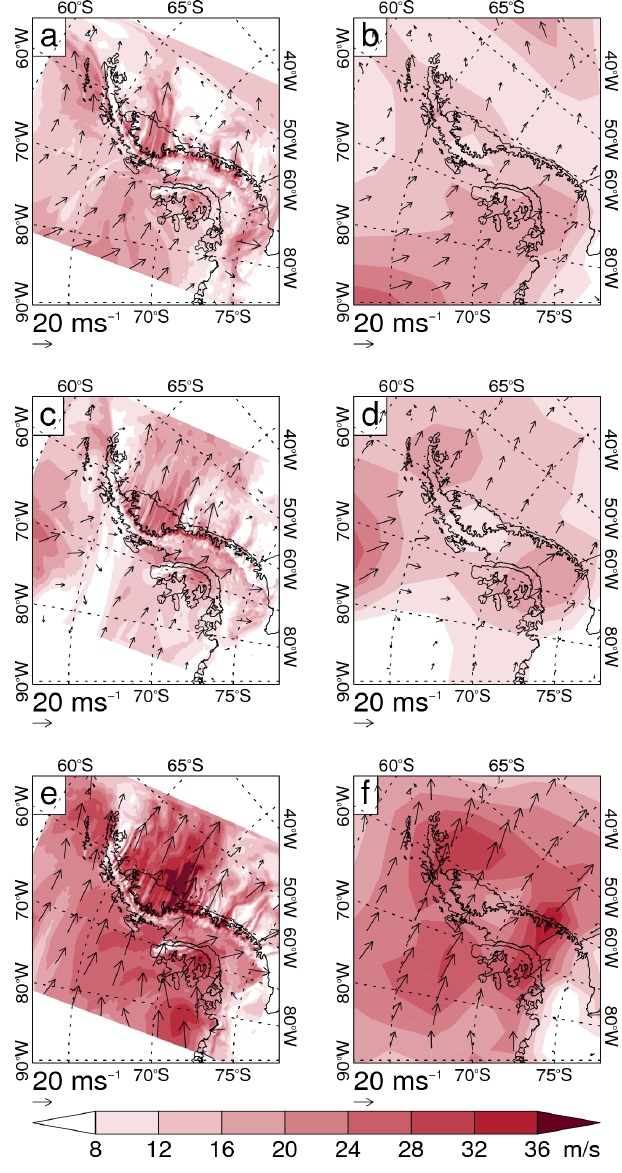
Figure 2. Mesoscale model (left) and climate model (right) simula- tion of the 850hPa wind field (ms − 1 ) over the AP at the time of the CS1 (a, b) , CS2 (c, d) , and CS3 (e, f) mountain wave events. See Ta- ble 1 for dates. The black arrows are wind vectors (for the mesoscale model only 1 in every 40 grid points is shown). The colour shading indicates the wind speed. Also shown is the coastline of the AP.